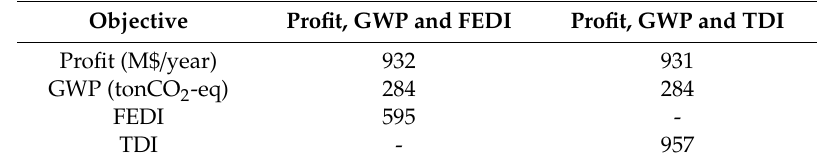
Table 14. Optimal objective values for the selected Pareto-optimal solutions in Figure 13.